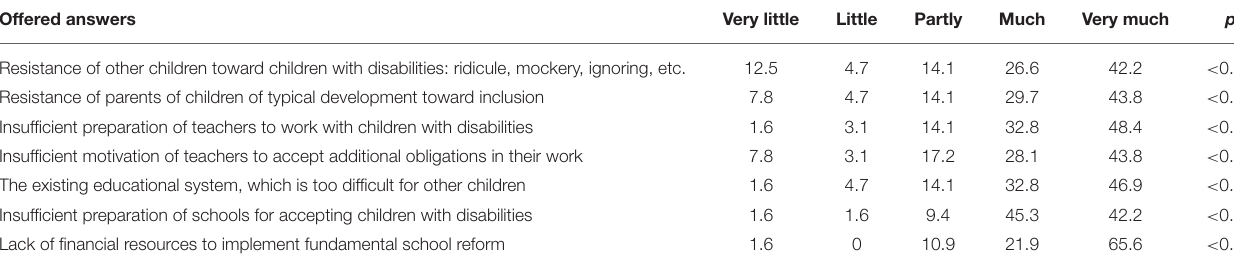
TABLE 4 | Factors that complicate the process of inclusion in